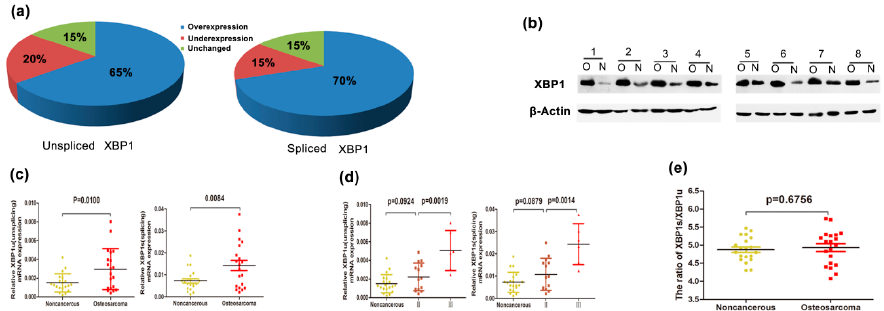
Figure 1. XBP1 is up-regulated in OS and correlated with the advanced clinical stage. ( a ) Relative expression of XBP1u and XBP1s were detected by RT-PCR in 20 pairs of OS clinical samples and their matched noncancerous tissues. The up-regulated XBP1u and XBP1s were, respectively, observed in 65% and 70% OS samples compared with the corresponding non-cancerous tissues; ( b ) XBP1 was overexpressed in OS clinical samples; Western blot tests showed XBP1 protein was higher in eight OS samples than their corresponding non-cancerous tissues. O: osteosarcoma; N: noncancerous; ( c ) Up-regulation of XBP1u and XBP1s was observed in 20 pairs OS comparing to their corresponding noncancerous tissue; ( d ) XBP1u and XBP1s mRNA expression in different clinical stages of OS; ( e ) The ratio of XBP1u to XBP1s. The dots in different color and sharp were used to differentiate different clinical stage. (Yellow for noncancerous tissue, Gray for stage II, Red for stage III). The patients were staged in accordance with the Ennecking musculoskeletal tumor staging system. Error bars represent mean ± s.d. of triplicate experiments. The statistical analysis was performed using paired t -test ( c , e ) and Student’s t -test ( d ). Table 1. Relationship between XBP1 mRNA expression and their clinicopathologic parameters in 20 of osteosarcoma.